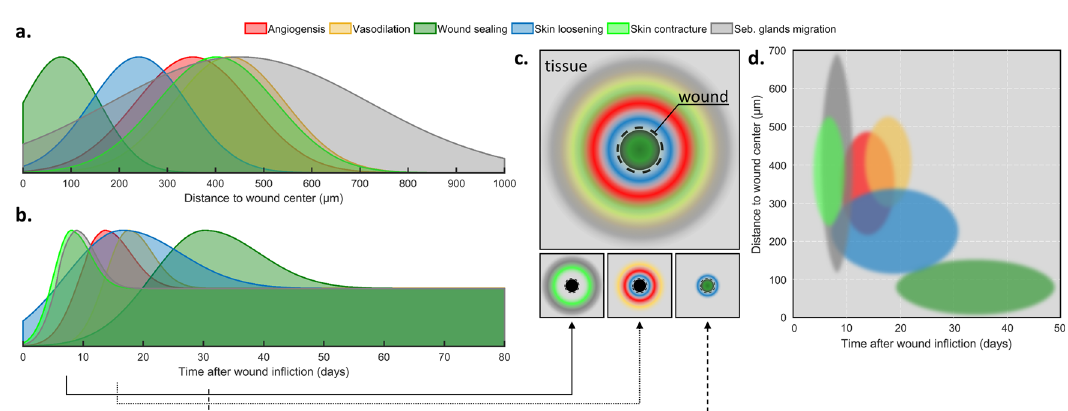
Fig. 5 Wound healing model in space and time based on spatio-temporal assessment by Co5M. a Temporal sequence and b spatial coordination of the investigated hallmarks. c Schematic depiction of the healing process in zones surrounding the wound, highlighted for three time points at day 8, 16, and 31. d Spatio-temporal diagram of healing